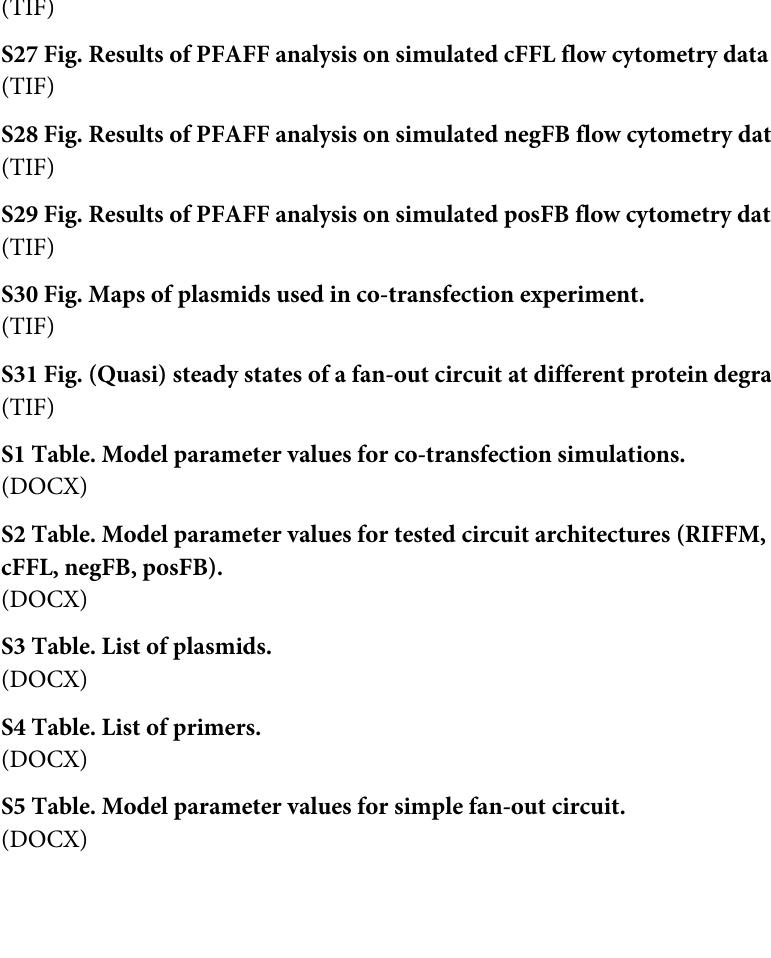
S27 Fig. Results of PFAFF analysis on simulated cFFL flow cytometry data sets.